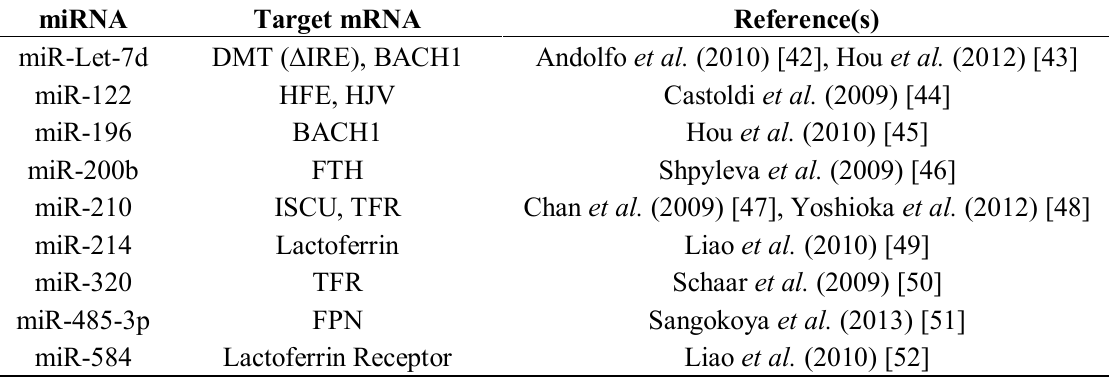
Table 1. Direct targets of miRNA associated with mammalian iron